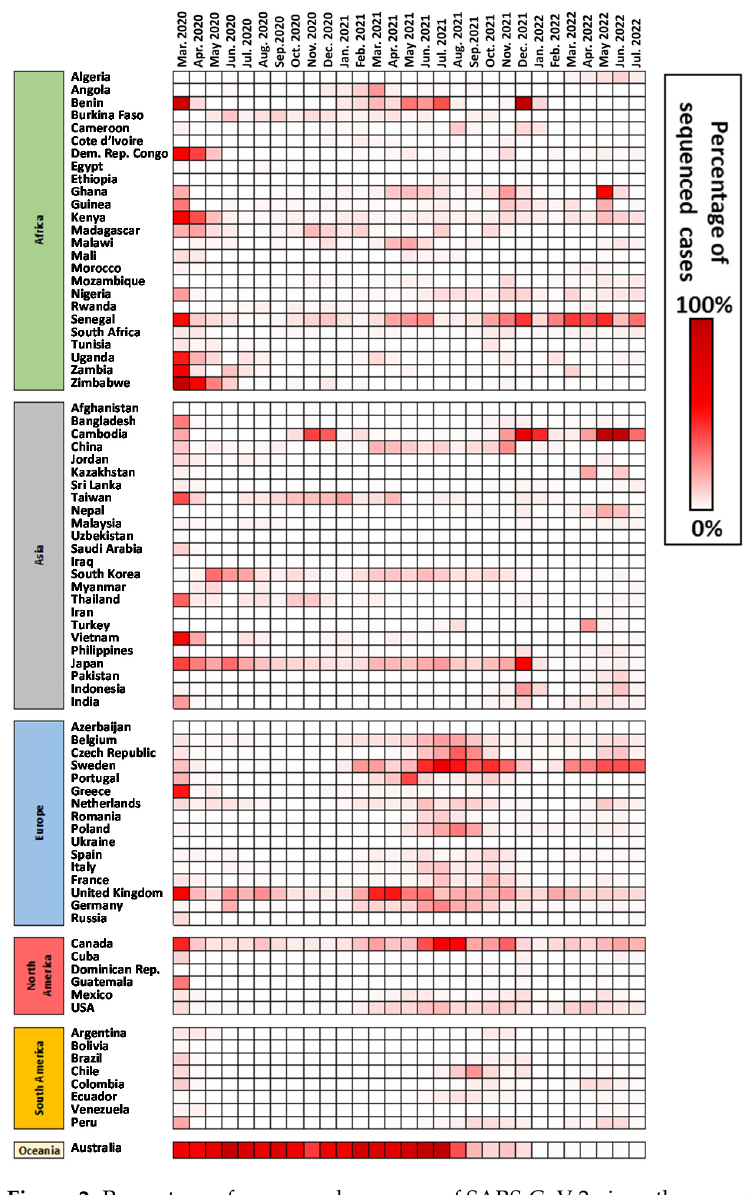
Figure 2. Percentage of sequenced genomes of SARS-CoV-2 given the reported incidence in different countries. Values displayed include months from March 2020 until July 2022.